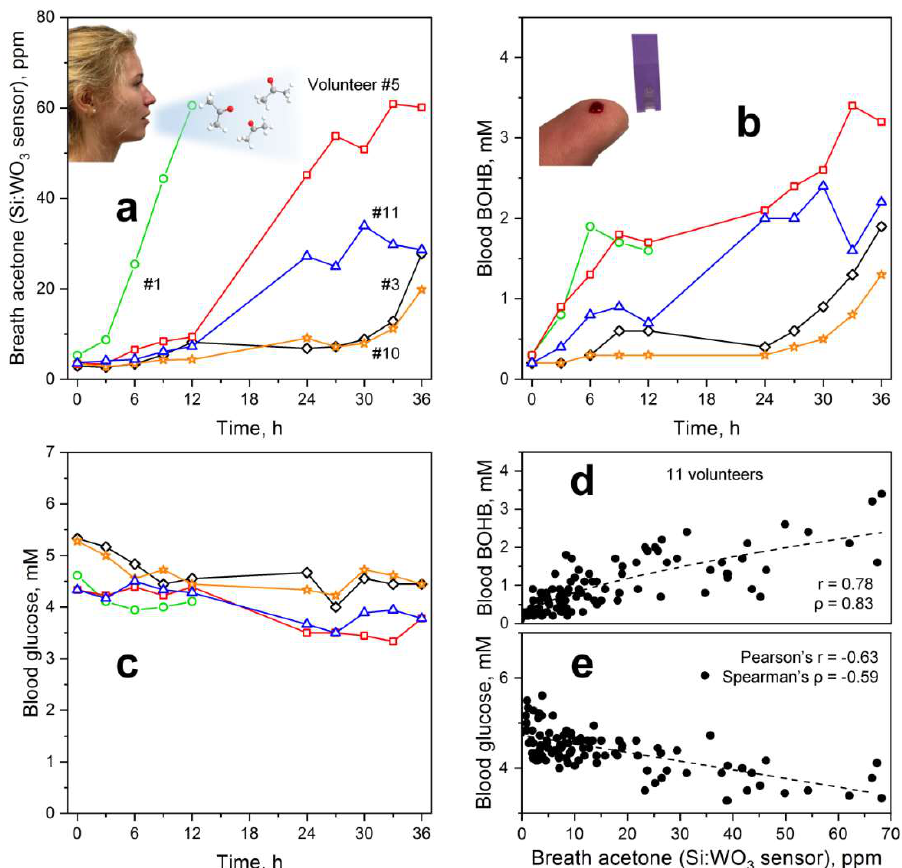
Figure 3. Individual ( a ) breath acetone levels as determined by the Si-doped WO 3 sensor, capillary blood ( b ) BOHB and ( c ) glucose concentrations of five representative volunteers during a 36-h KD. Note that volunteer #1 (green circles) had to abort the experiment already after 24 h due to strong nausea. Scatter plot of ( d ) BOHB and ( e ) glucose versus acetone concentrations for all eleven volunteers (105 samples) with corresponding Pearson’s (r) and Spearman’s ( ρ ) correlation coefficients. Dashed lines indicate fitted (power law in d and linear in e) trend lines.